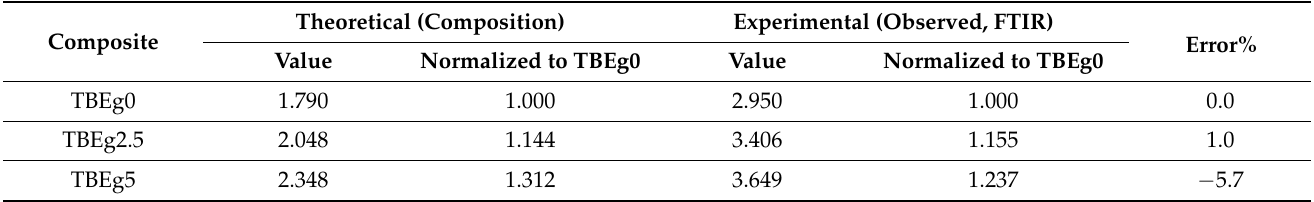
Table 2. Mole ratio between the aliphatic (vinylic) and aromatic C=C bonds calculated theoretically from the composition and experimentally from FTIR spectra. For easy comparison, values were normalized to the control (1.00) in both